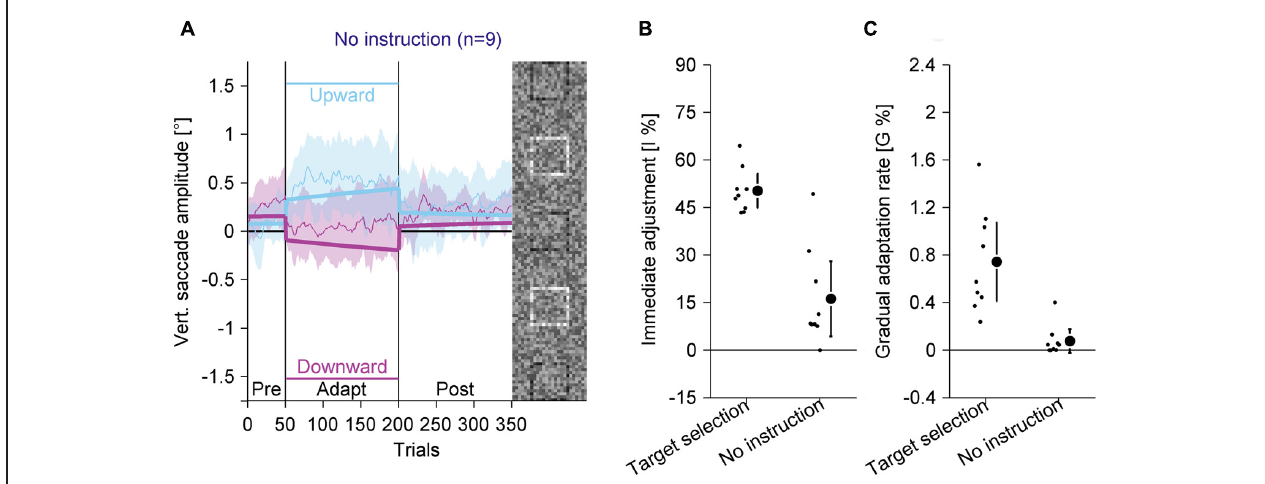
FIGURE 7 | Experiment 4, saccadic behavior with identical stimuli as in Experiment 3, but without instruction for target selection and without perceptual task. (A) Saccadic behavior without instruction for target selection. (B) Immediate adjustment in the two-state model fits. (C) Gradual adaptation rate in the two-state model fits. (B,C) Data from the target selection condition from Experiment 3 are replotted. (A–C) Conventions are the same as in Figure 3 .